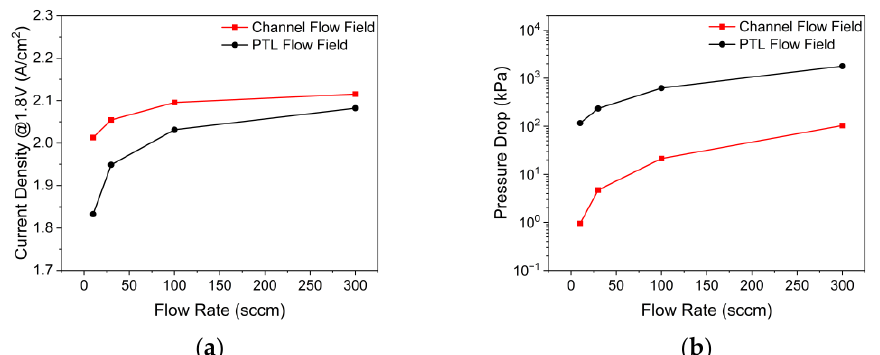
Figure 16. Effects of flow rate on the (a) current density and (b) pressure drop according to the anode flow field of PEMWE ( ε : 0.75, K : 30.2 × 10 −12 m 2 , θ : 30°, 𝑄̇ 𝑖𝑛 : 10 sccm, T in : 328.15 K, T cell : 328.15 K, V op : 1.8 V).